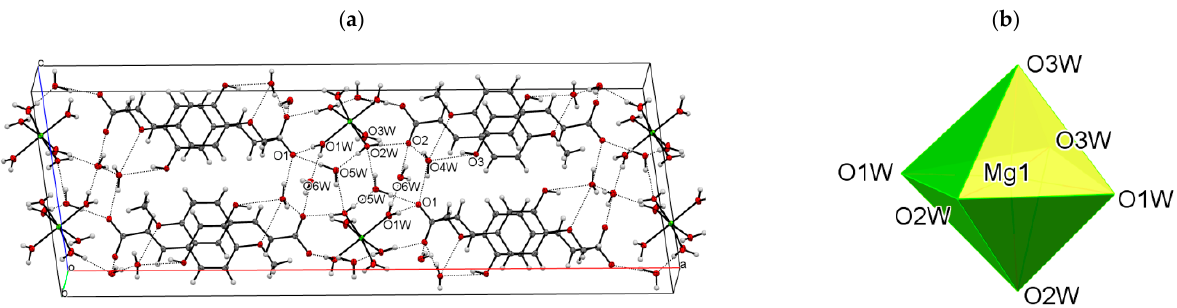
Figure 2. The asymmetric unit of: ( a ) [Mg(H 2 O) 6 ]  (C 10 H 9 O 4 ) 2  6H 2 O) and ( b ) [Mn 3 Na 2 (C 10 H 7 O 4 ) 8 (H 2 O) 8 ] n with the atom ‐ labeling scheme. Displacement ellipsoids are drawn at the 50% probability level. Dashed lines indicate hydrogen bonds. Symmetry code: (i) ‐ x, y, ‐ z +1/2.